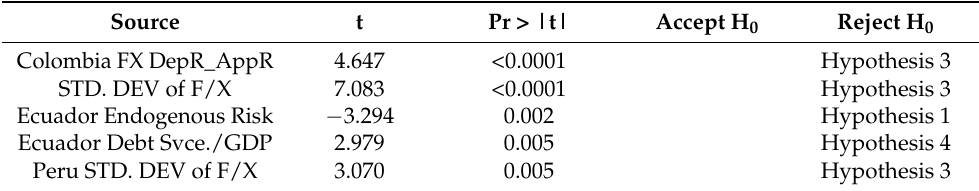
Table 2. Significant variables and Hypotheses test against Average EMBI